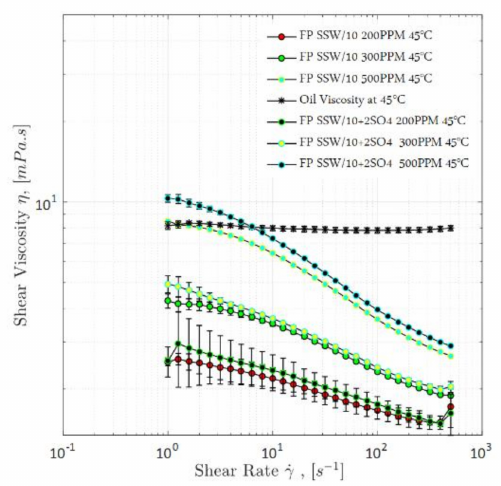
Figure 5. Steady-shear viscosity of polymer solutions at a temperature of 45 ◦ C. Polymer solutions are prepared in Brine 3 and Brine 4 of Table 2 with concentrations of 200, 300 and 500 ppm.